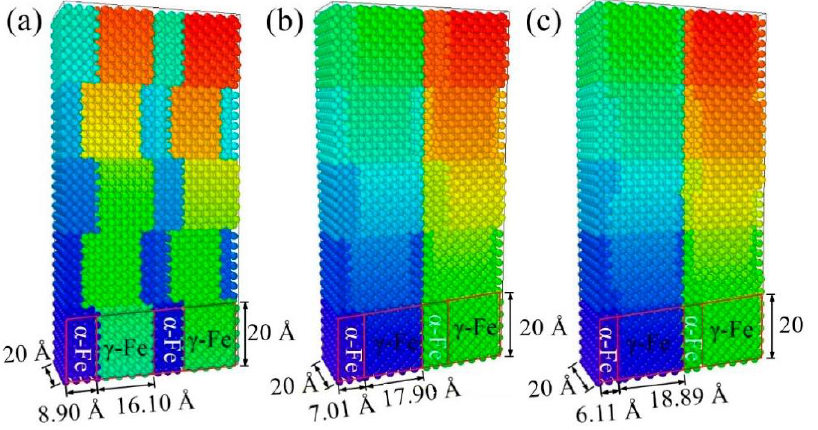
Figure 8. The models with different volume ratios of ferrite and austenite ( a ) 35.6% ferrite + 64.4% austenite; ( b ) 28.2% ferrite + 71.8% austenite; ( c ) 24.4% ferrite + 75.6% austenite.